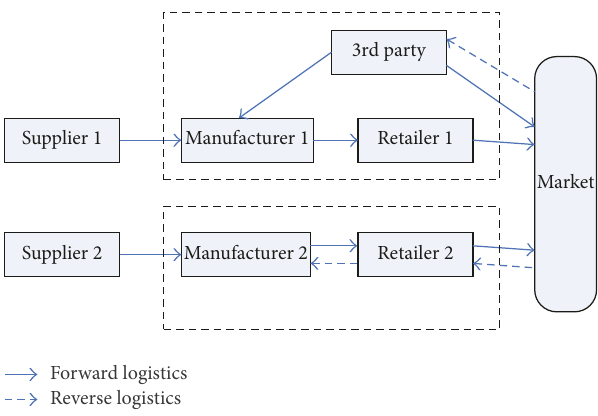
Figure 1: Recycling competition structure